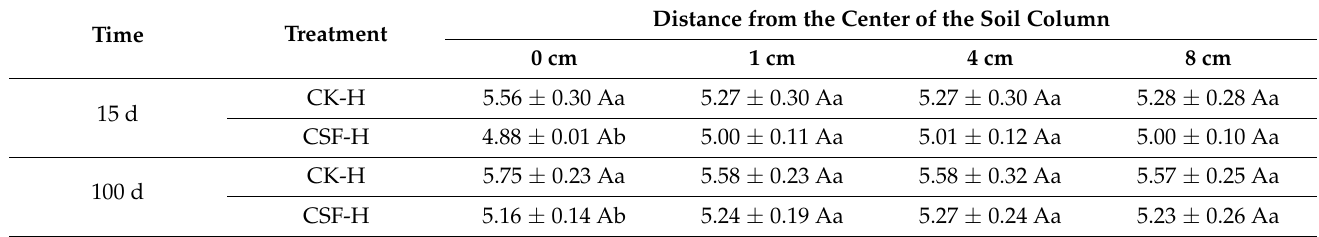
Table 2. The change of pH in different horizontal soil layers with CSF addition.